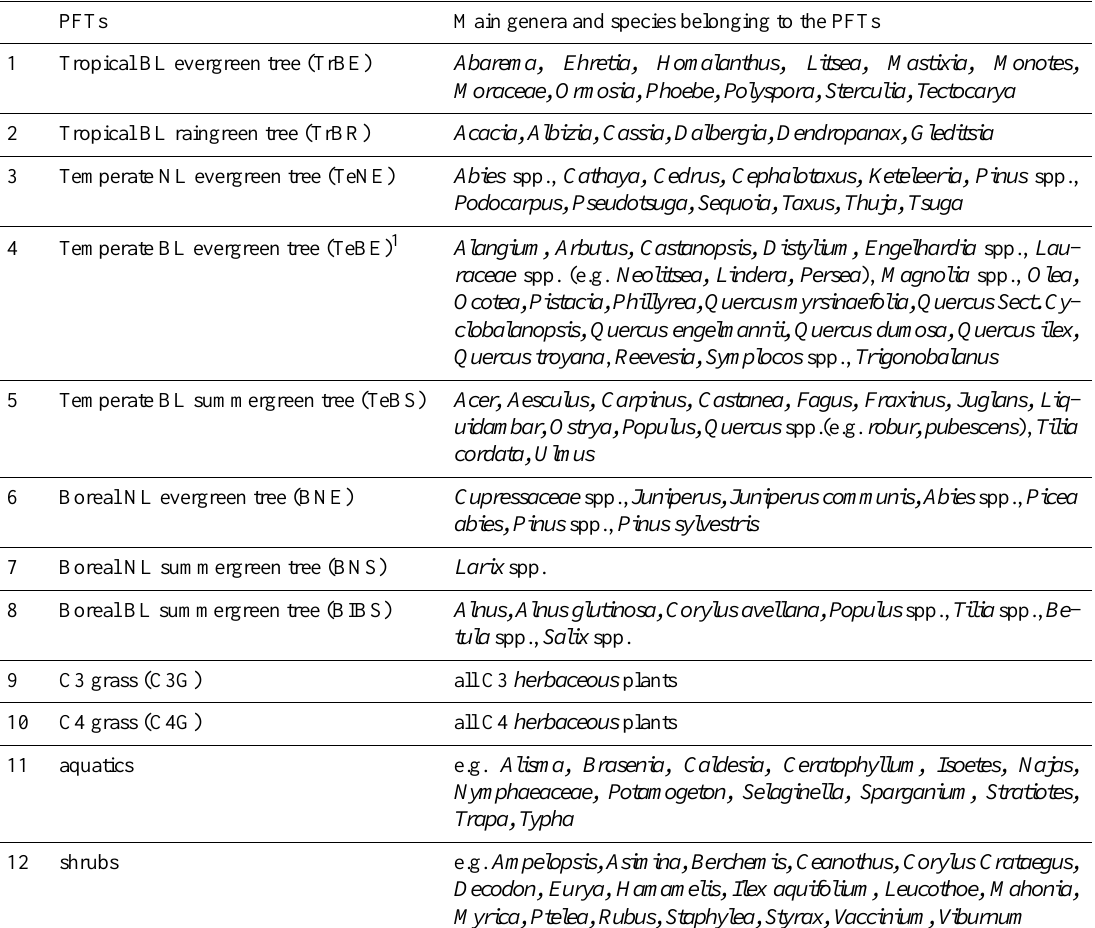
Table F2. Model PFTs and corresponding main genera and species represented in the late Miocene fossil record. Shrubs and aquatics were not simulated in the vegetation